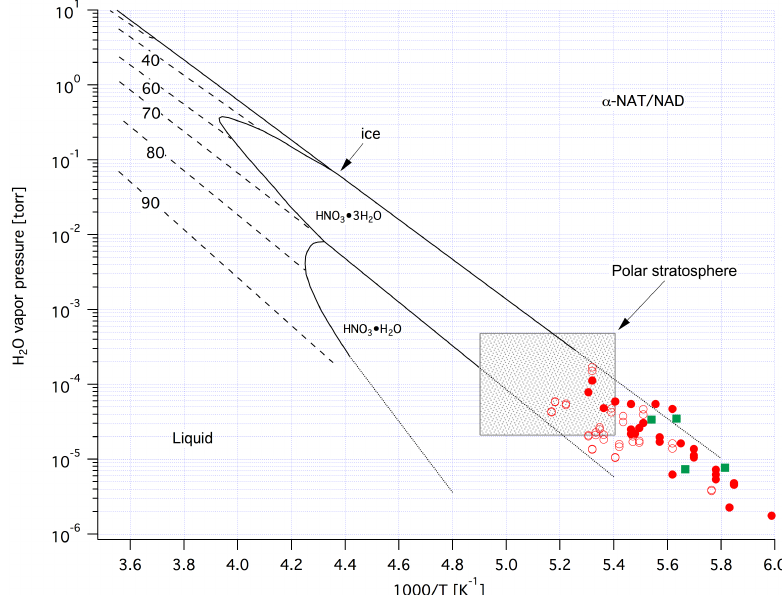
Figure 3. Binary phase diagram of the HNO 3 / H 2 O system reconstructed from McElroy et al. (1986), Hamill et al. (1988) and Molina (1994). The full symbols represent calculated values of P eq (H 2 O) for α -NAT and NAD using the kinetic data of PV experiments. Empty circles represent calculated values of P eq (H 2 O) for α -NAT using the kinetic data of two-orifice (TO) experiments. The solid lines represent the coexistence conditions for two phases, and the dashed lines represent vapor pressures of liquids with composition given as % ( w/w ) of HNO 3 . The shaded gray area represents polar stratospheric